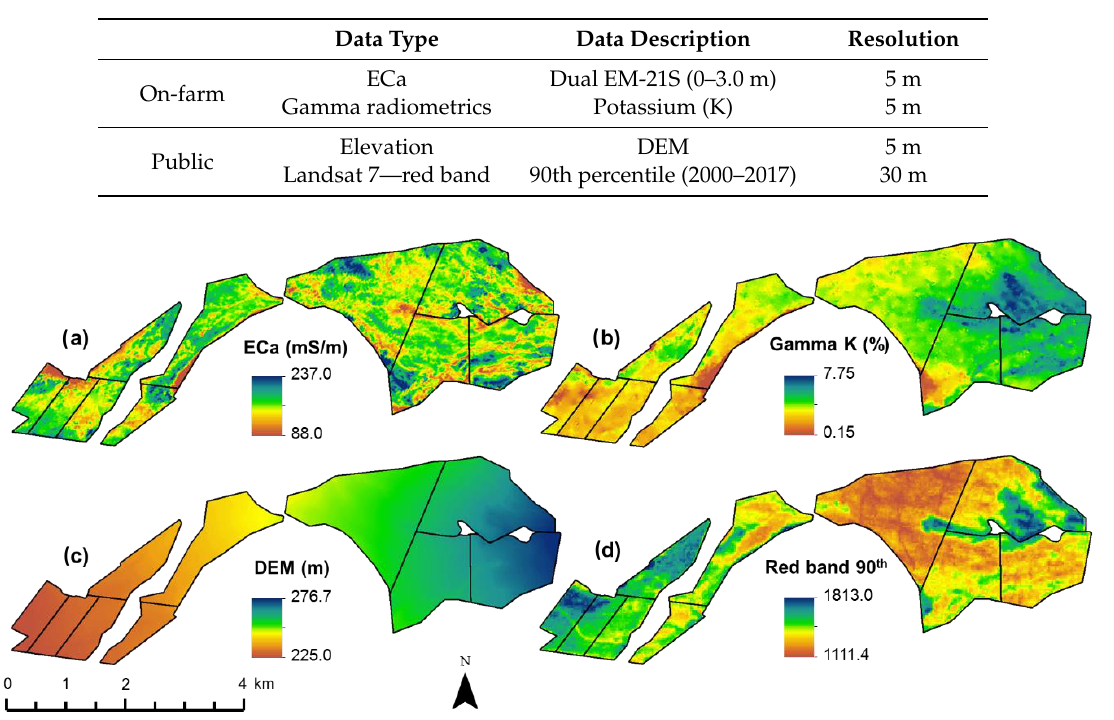
Figure 3. The data sources used for digital soil mapping. ( a ) Soil ECa (0 – 3.0 m) from a Dual EM-21S, ( b ) Gamma radiometrics K, ( c ) DEM, and ( d ) the 90th percentile (2000 – 2017) red band from Landsat 7.